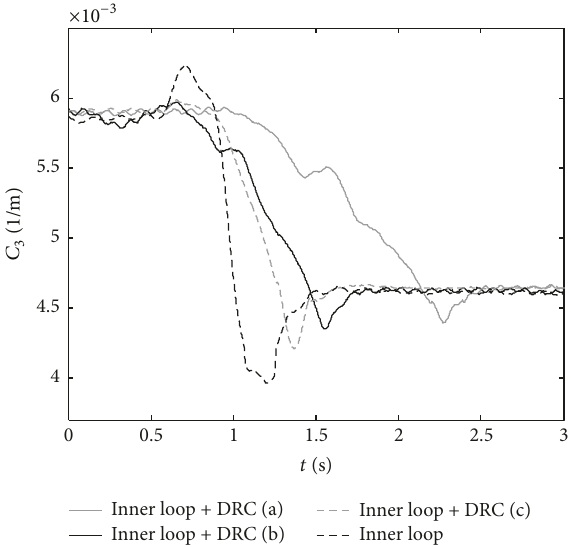
Figure 7: Comparison of the follower